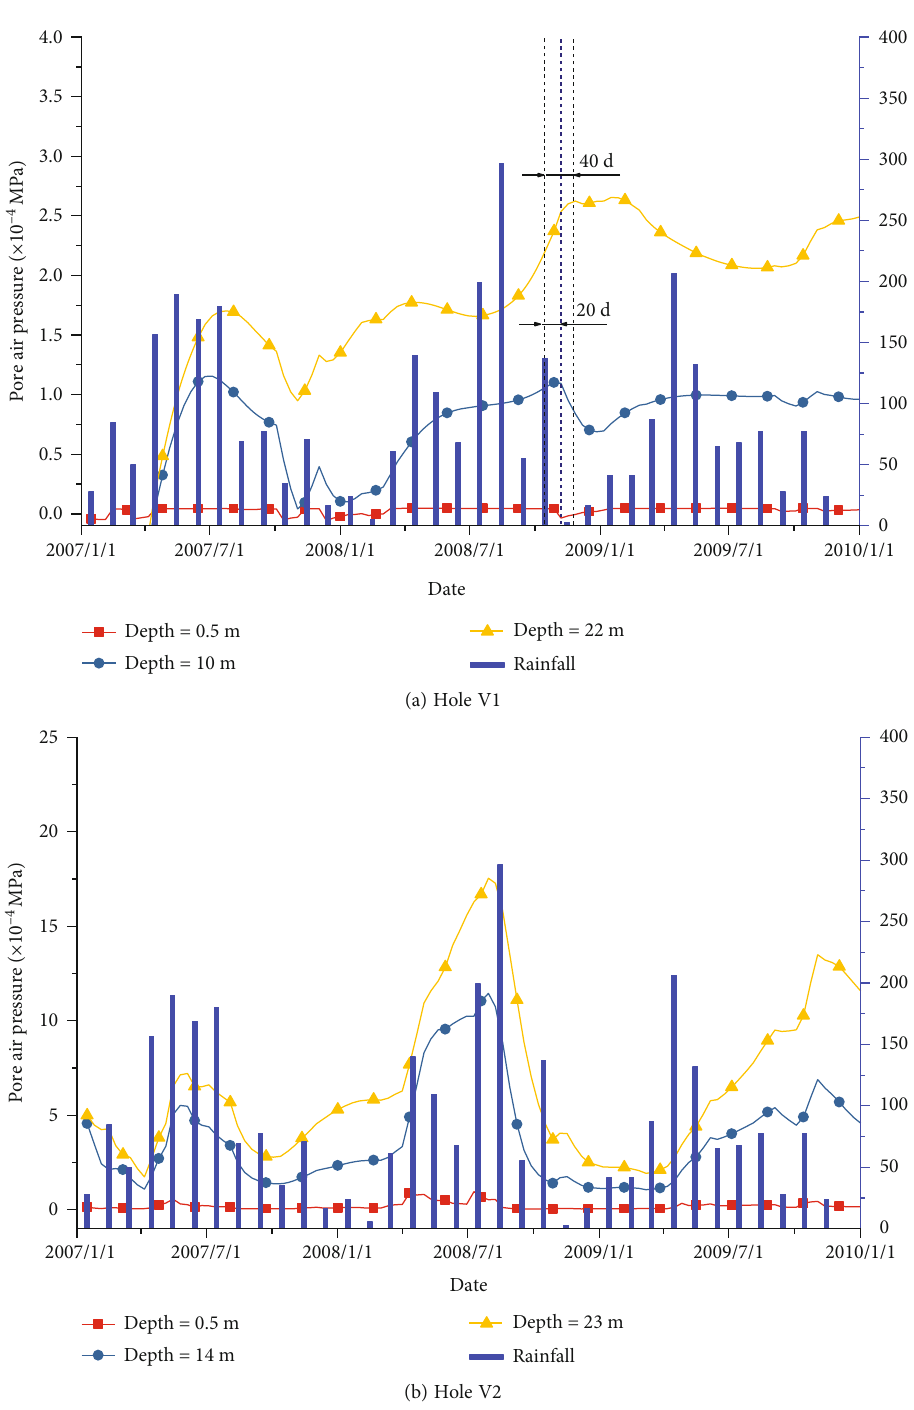
Figure 9: Pore-air pressure evolutions at di ff erent